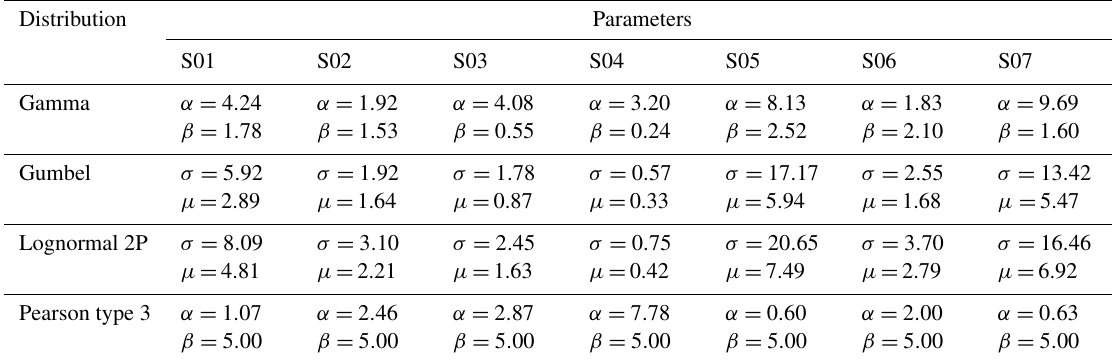
Table 5. Estimated parameters for the gamma, Gumbel, lognormal 2P and Pearson type 3 distributions. Distribution